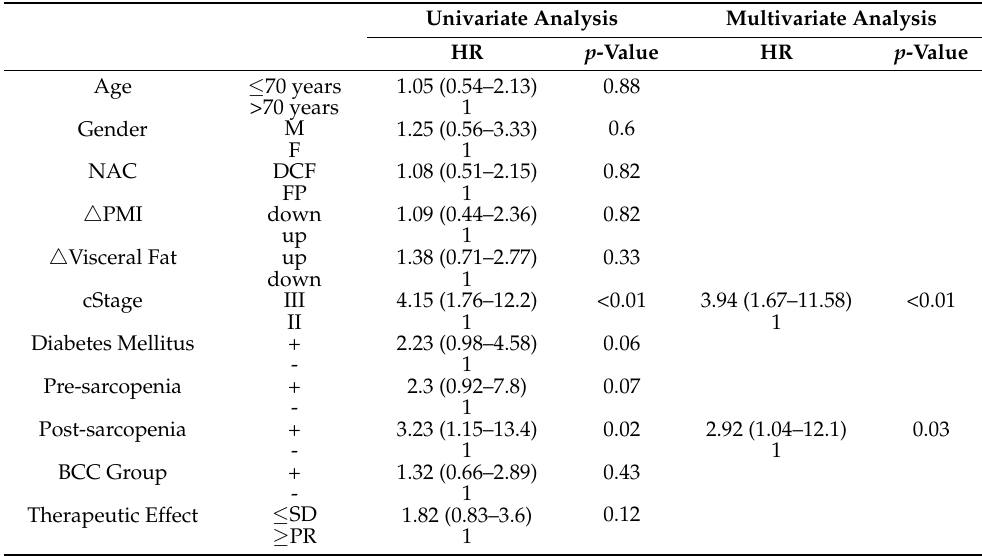
Table 6. Cox proportional hazard model of overall survival (OS) using univariate and multivariate analyses. Univariate